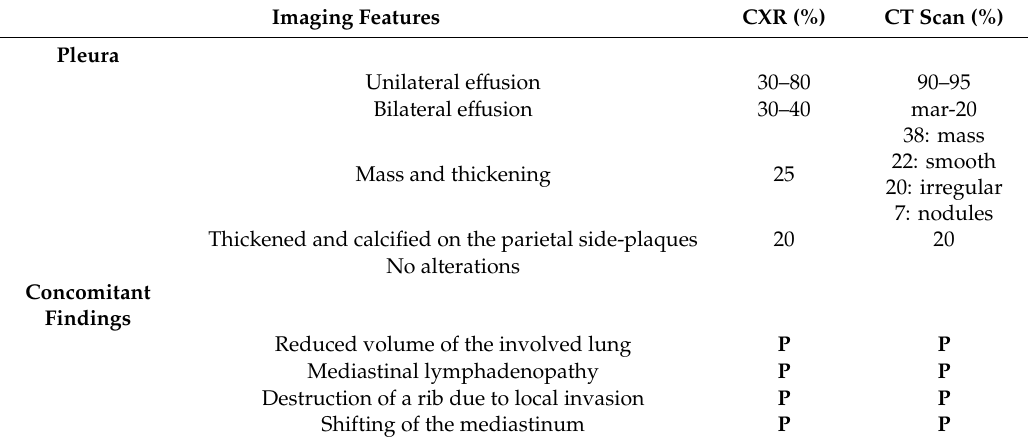
Table 1. Imaging features of MPM (Malignant Pleural Mesothelioma). Detection of pathologic findings (in percentages) in the pleural layers and other thoracic districts through chest X rays (CXR) and CT (computed tomography) scan. Percentages of detection of pathologic findings have been obtained from literature revision